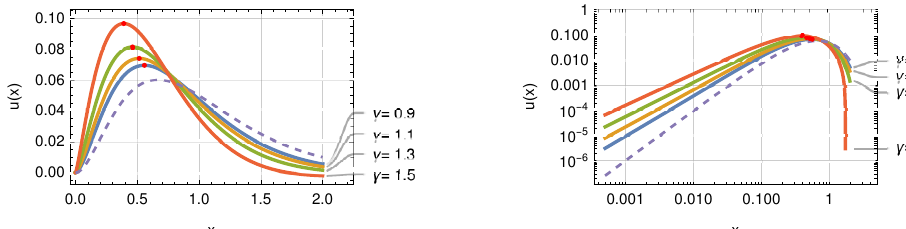
Figure 16. Variation of parameters (indicated in the panels) for the convolution integral (56) using ( − x ) = ˜ E ( − x ) based on ℵ functions. The parameters are a weighted Mittag-Leffler function E δ , γ α , β α , β α = 1/2 and β = 1/3. The top row uses γ = 2 and the bottom row δ = 2. The number of Sinc points in all approximations is N = 48. The inhomogeneity used is f ( x ) = x 2 exp ( − 3 x ) (dashed